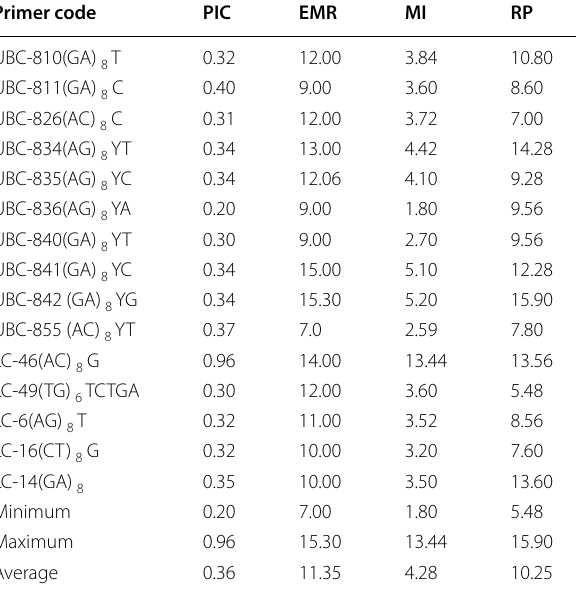
Table 4 Marker parameters calculated for selected ISSR primers Primer code